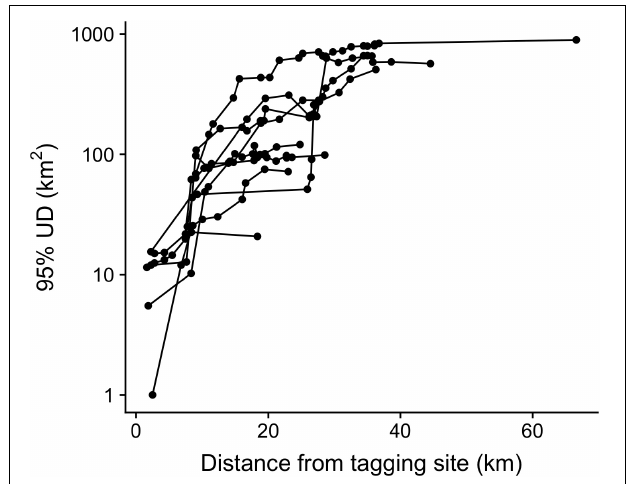
FIGURE 8 | 95% KUD estimates relative to spacing of acoustic receivers in the array based on dBBMM. Model used the data from a single tag, for simulated arrays with minimum receiver spacing varying from 0 to 10 km. 10 random array simulations were used to generate mean values at each density value. Black line and gray band shows mean and 95% confidence interval, respectively, of the log-linear relationship between dBBMM estimates and array density ( R 2 = 0.54, p = 0.016).